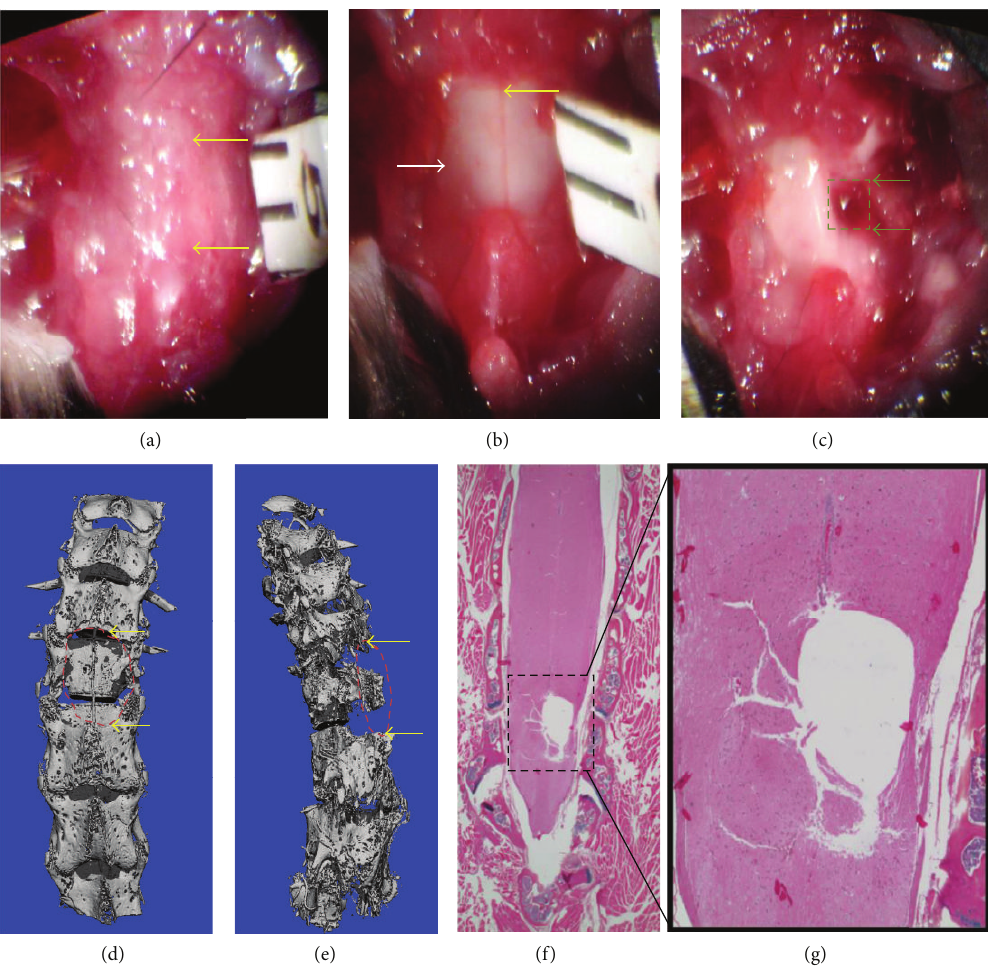
Figure 1: A murine laminectomy and hemisection model of TSCI. Development of a murine laminectomy and hemisection model of TSCI was achieved using protocols approved by the University of Rochester Committee for Animal Resources (IACUC). After the animal is anesthetized, a laminectomy is performed to remove thorax 11 lamina (a), then the dura is opened to expose the spinal cord (b), and, finally, a hemisection lesion is performed to generate a 2mm defect in the right half side of the spinal cord (c). Postoperatire dorsal view (d) and lateral view (e) of micro-CT scans of the spine; 5x (f) and 20x (g) micrographs of H&E stained histology sections are presented to illustrate the vertebral bone and spinal cord defects that generated in this model,